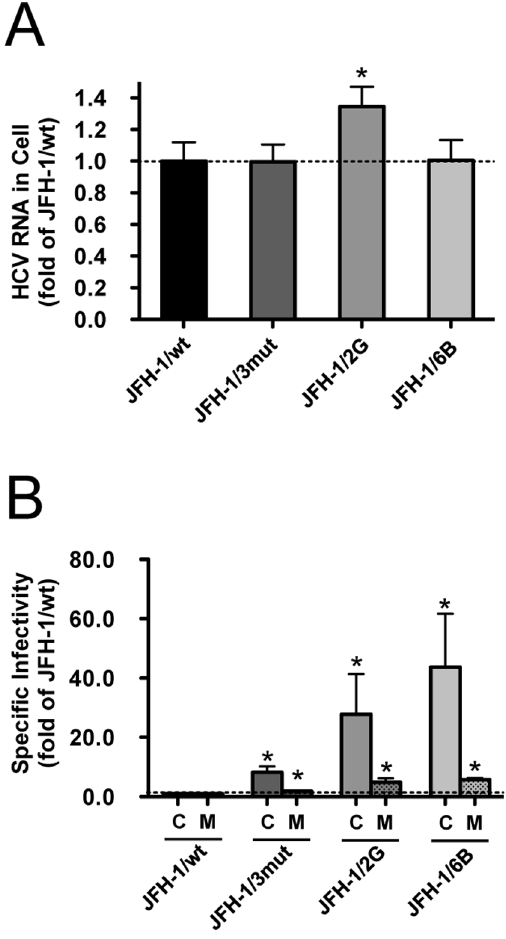
Figure 8. Single cycle virus production assay to assess the contribution of introduced mutations on viral life cycle. (A) Intra-cellular HCV RNA titers were assessed in full-length RNA of JFH-1/ wt-, JFH-1/3mut-, JFH-1/2G- and JFH-1/6B-transfected Huh7–25 cells. Data are presented as fold change vs. JFH-1/wt. (B) Intra- and extra- cellular specific infectivity of JFH-1/wt-, JFH-1/3mut-, JFH-1/2G- and JFH-1/6B-transfected Huh7–25 cells were calculated. Data are given as fold change vs. JFH-1/wt. C; intracellular specific infectivity, M; extracellular specific infectivity, * p , 0.05.